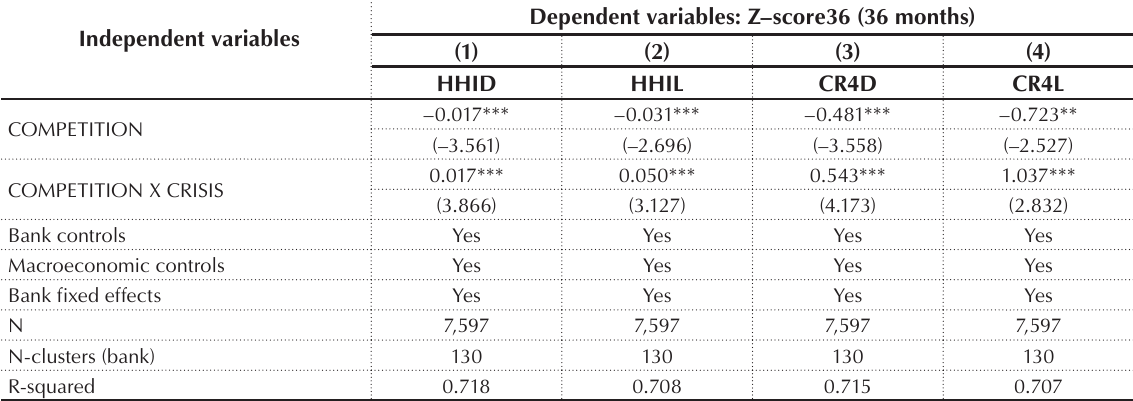
Table (cid:1009). (cid:18)(cid:381)(cid:373)(cid:393)(cid:286)(cid:415)(cid:415)(cid:381)(cid:374)(cid:3)(cid:258)(cid:374)(cid:282)(cid:3)(cid:271)(cid:258)(cid:374)(cid:364)(cid:3)(cid:296)(cid:396)(cid:258)(cid:336)(cid:349)(cid:367)(cid:349)(cid:410)(cid:455)(cid:3)(cid:349)(cid:374)(cid:3)(cid:374)(cid:381)(cid:396)(cid:373)(cid:258)(cid:367)(cid:3)(cid:415)(cid:373)(cid:286)(cid:400)(cid:3)(cid:258)(cid:374)(cid:282)(cid:3)(cid:302)(cid:374)(cid:258)(cid:374)(cid:272)(cid:349)(cid:258)(cid:367)(cid:3)(cid:272)(cid:396)(cid:349)(cid:400)(cid:349)(cid:400) Independent